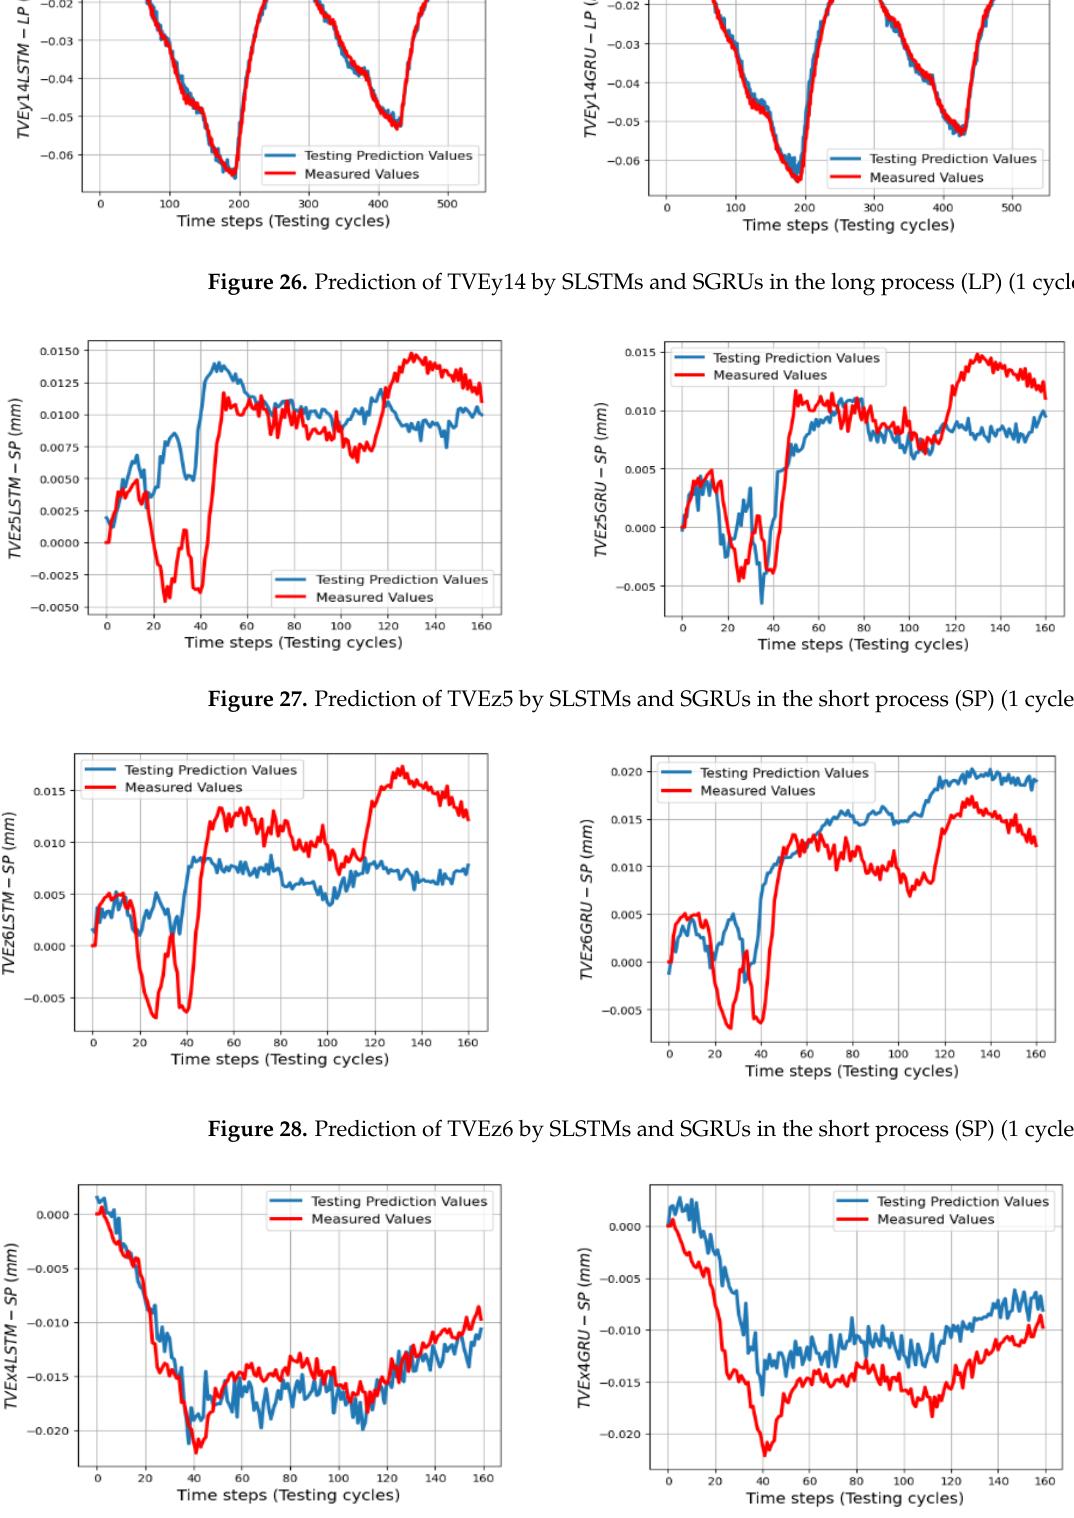
Figure 29. Prediction of TVEx4 by SLSTMs and SGRUs in the short process (SP) (1 cycle = 15 min) .